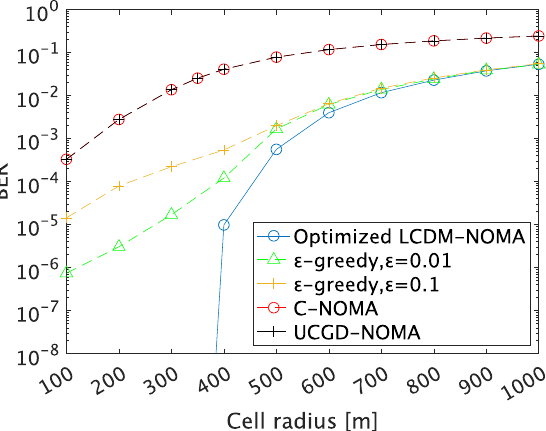
Figure 12. BER comparison with C-NOM, UCGD-NOMA, and (cid:101) -greedy-based user pairing